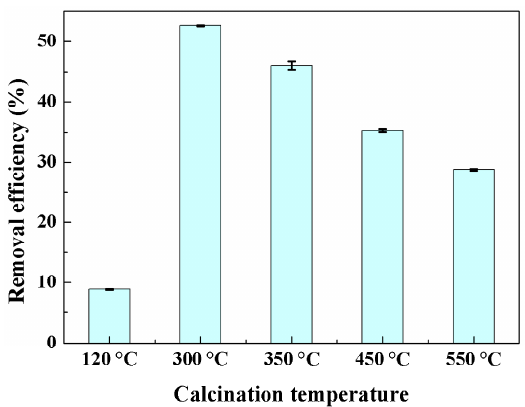
Figure 7. UV–VIS spectra of MB ( a ), MV ( b ), and MG solutions ( c ) after adsorption by C/APT-Re1; digital photographs of the MB, MV, and MG solutions.